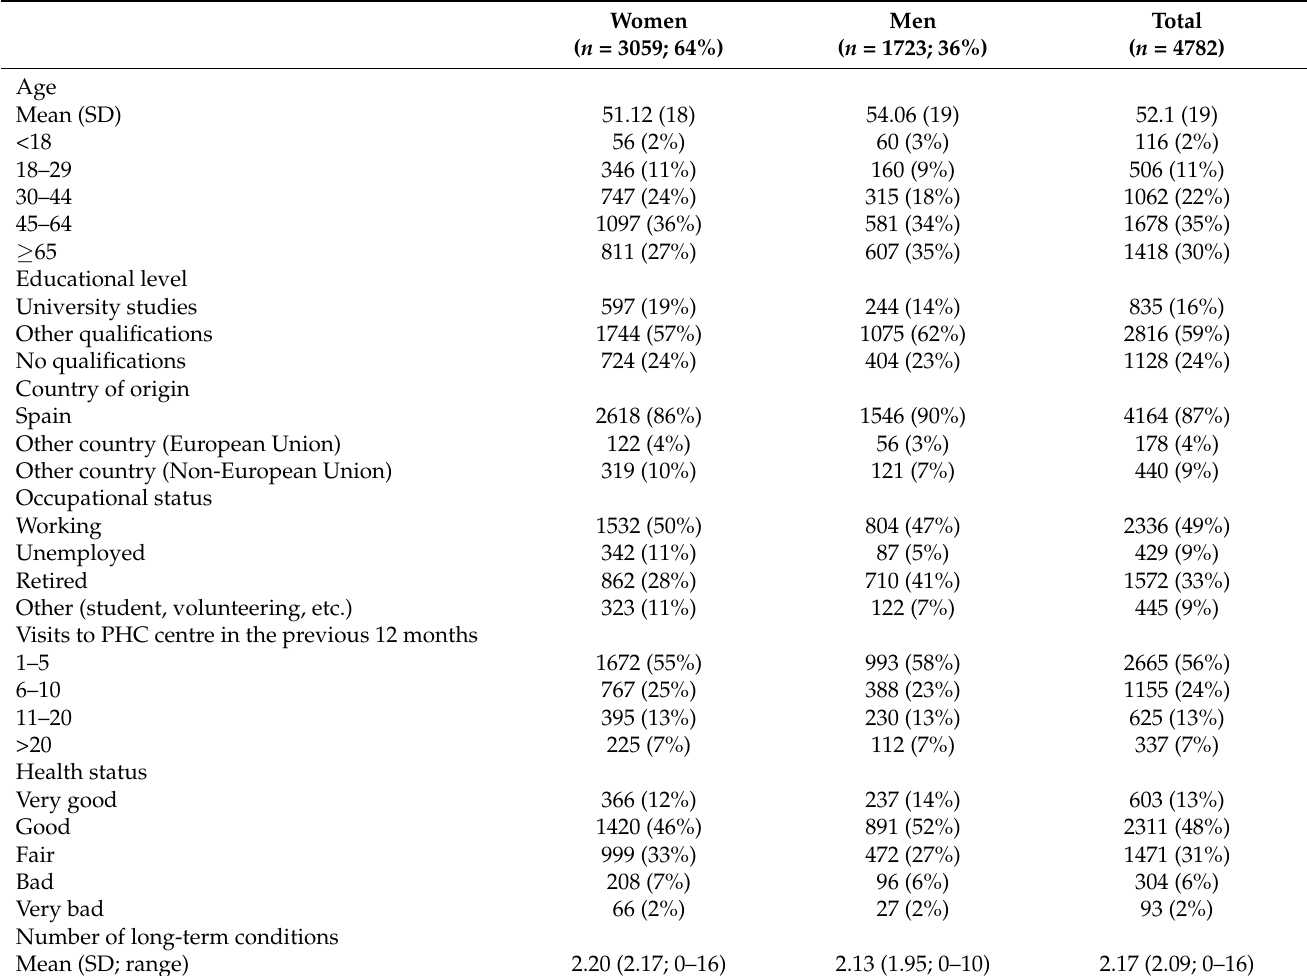
Table 1. Sociodemographic and clinical characteristics of the